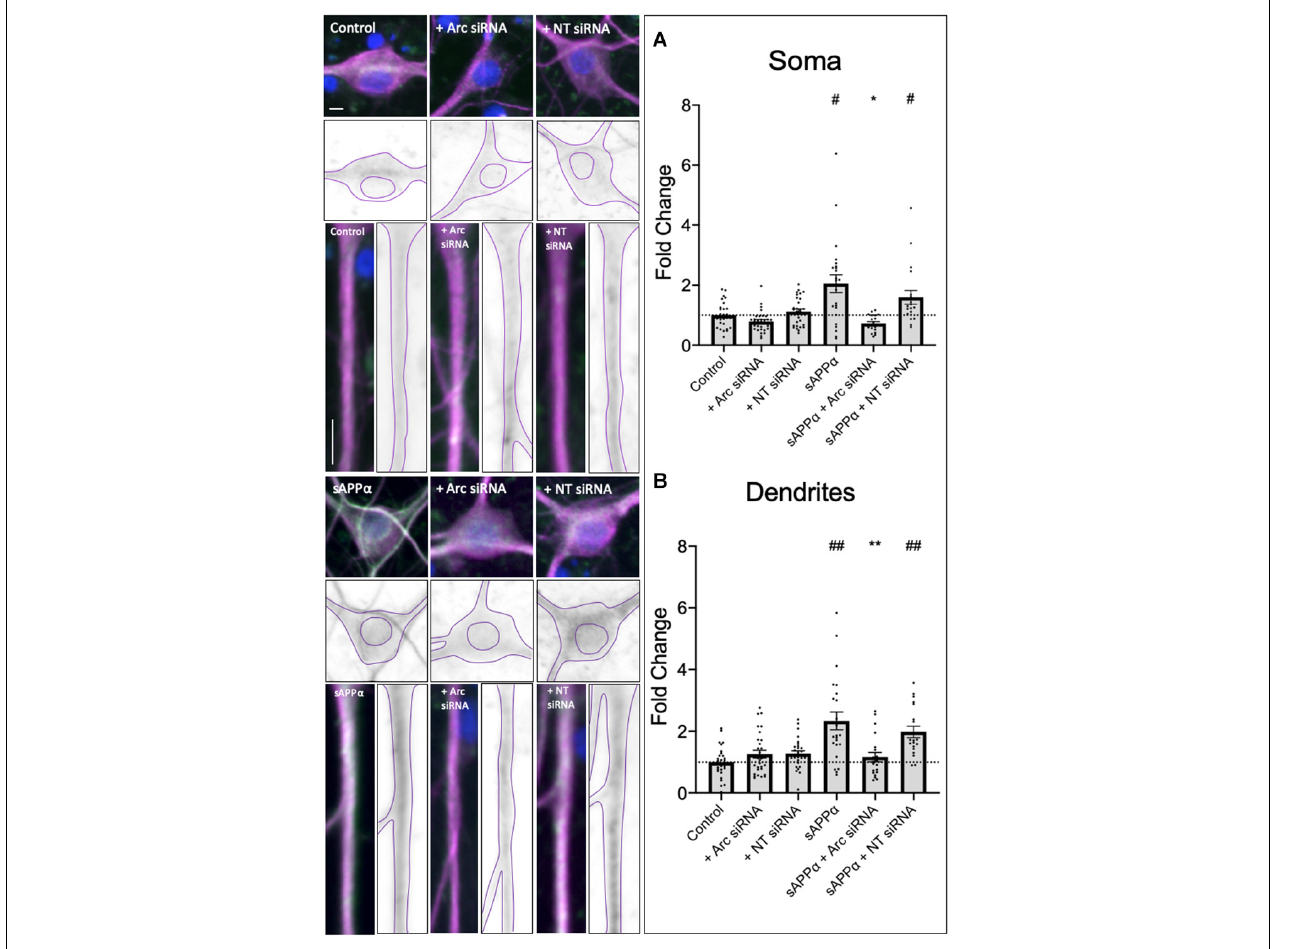
FIGURE 4 | Secreted amyloid precursor protein-alpha promoted Arc expression is affected by AccellTM Arc siRNA. Representative images show Arc protein levels the soma (upper panels) and dendrites (lower panels) in control and sAPP α -treated primary hippocampal neurons ± co-treatment with Arc siRNA or non-targeted (NT) control siRNA. In both the (A) soma and (B) dendrites ( n = 19–30), sAPP α treatment significantly enhanced Arc expression in sAPP α -only and sAPP α + NT siRNA conditions. This effect was inhibited by co-treatment with the Arc siRNA. Outliers were removed from each experiment prior to amalgamation using Grubb’s tests, and normality was detected by D’Agostino and Pearson omnibus normality tests. Significance was calculated using a Kruskal–Wallis one-way ANOVA with Dunn’s multiple comparisons test on raw data, and expressed as fold change relative to the experimental control. All data are expressed relative to control, as mean ± SEM from 3 experiments. Hashes (#) denote significant difference from control, asterisks (*) denote significant difference from sAPP α -treated. # /* p ≤ 0.05, **/ ## p ≤ 0.005. Representative images show neuronal soma, dendrites (MAP2, (cid:4) ), Arc protein ( (cid:4) ), nuclei (DAPI, (cid:4) ). Scale bars = 10 µ